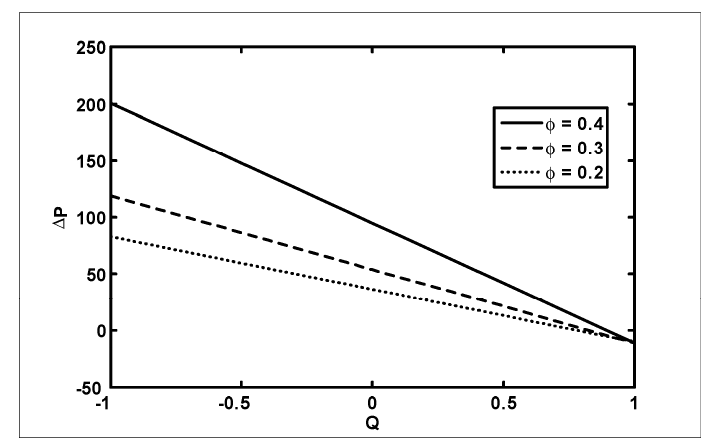
Δ Figure 6. The variation of ∆ p with Q for di ff erent values of ϕ at M = 3, r 1 = 0.1, when µ = r Figure 6. The variation of p with Q for different values of φ at ,1.0,3 . r =μ